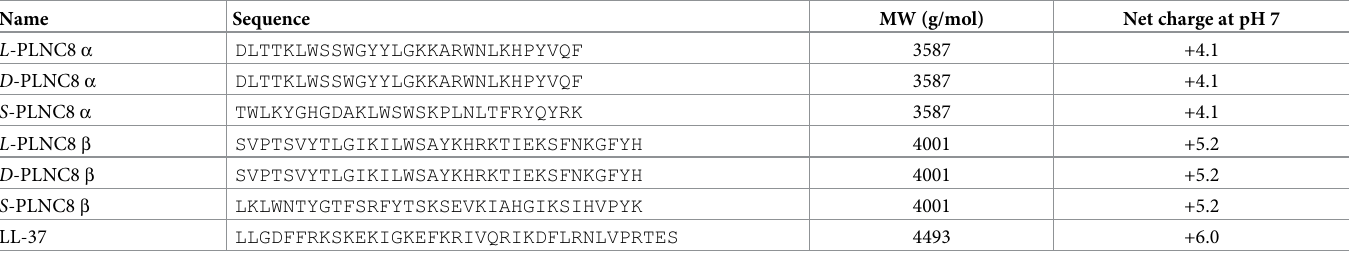
Table 1. Amino acid sequence, molecular weight, and net charge at pH 7 of the peptides L -PLNC8 αβ [11], D -PLNC8 αβ , S -PLNC8 αβ [16], and LL-37 that were used in this study.